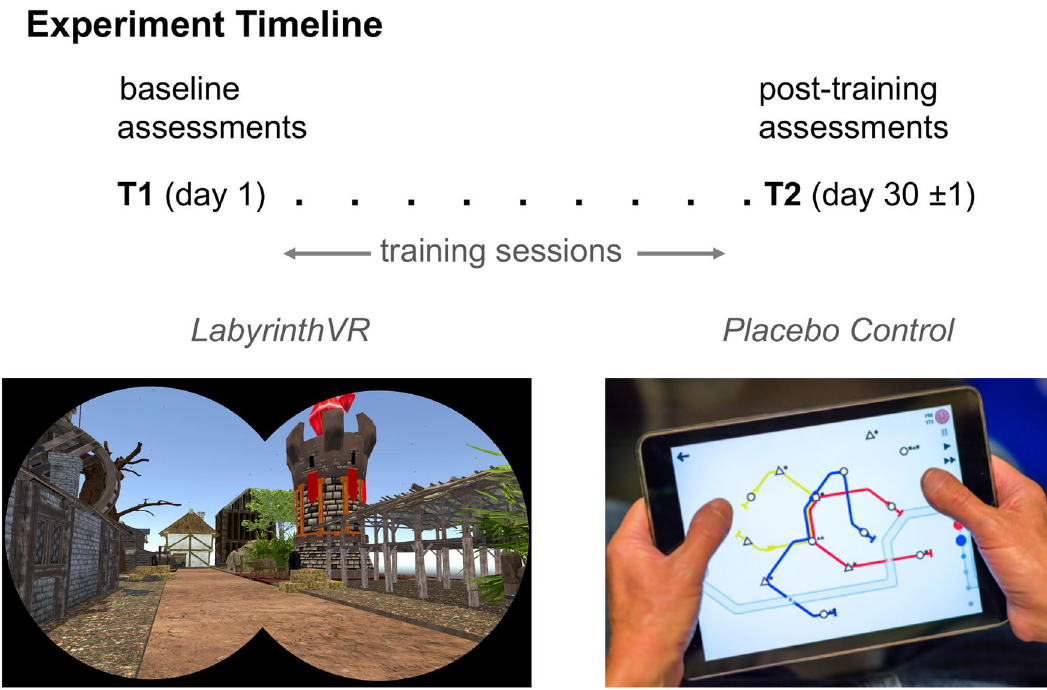
Figure 2. Overview of Procedures in Experiment 2. Participants were randomized to training regimens that included 12 h on task playing either the Labyrinth-VR or the Placebo Control games over 30 days. Baseline and post-training performance on high-fidelity LTM outcomes were assessed promptly before and after each participant’s training